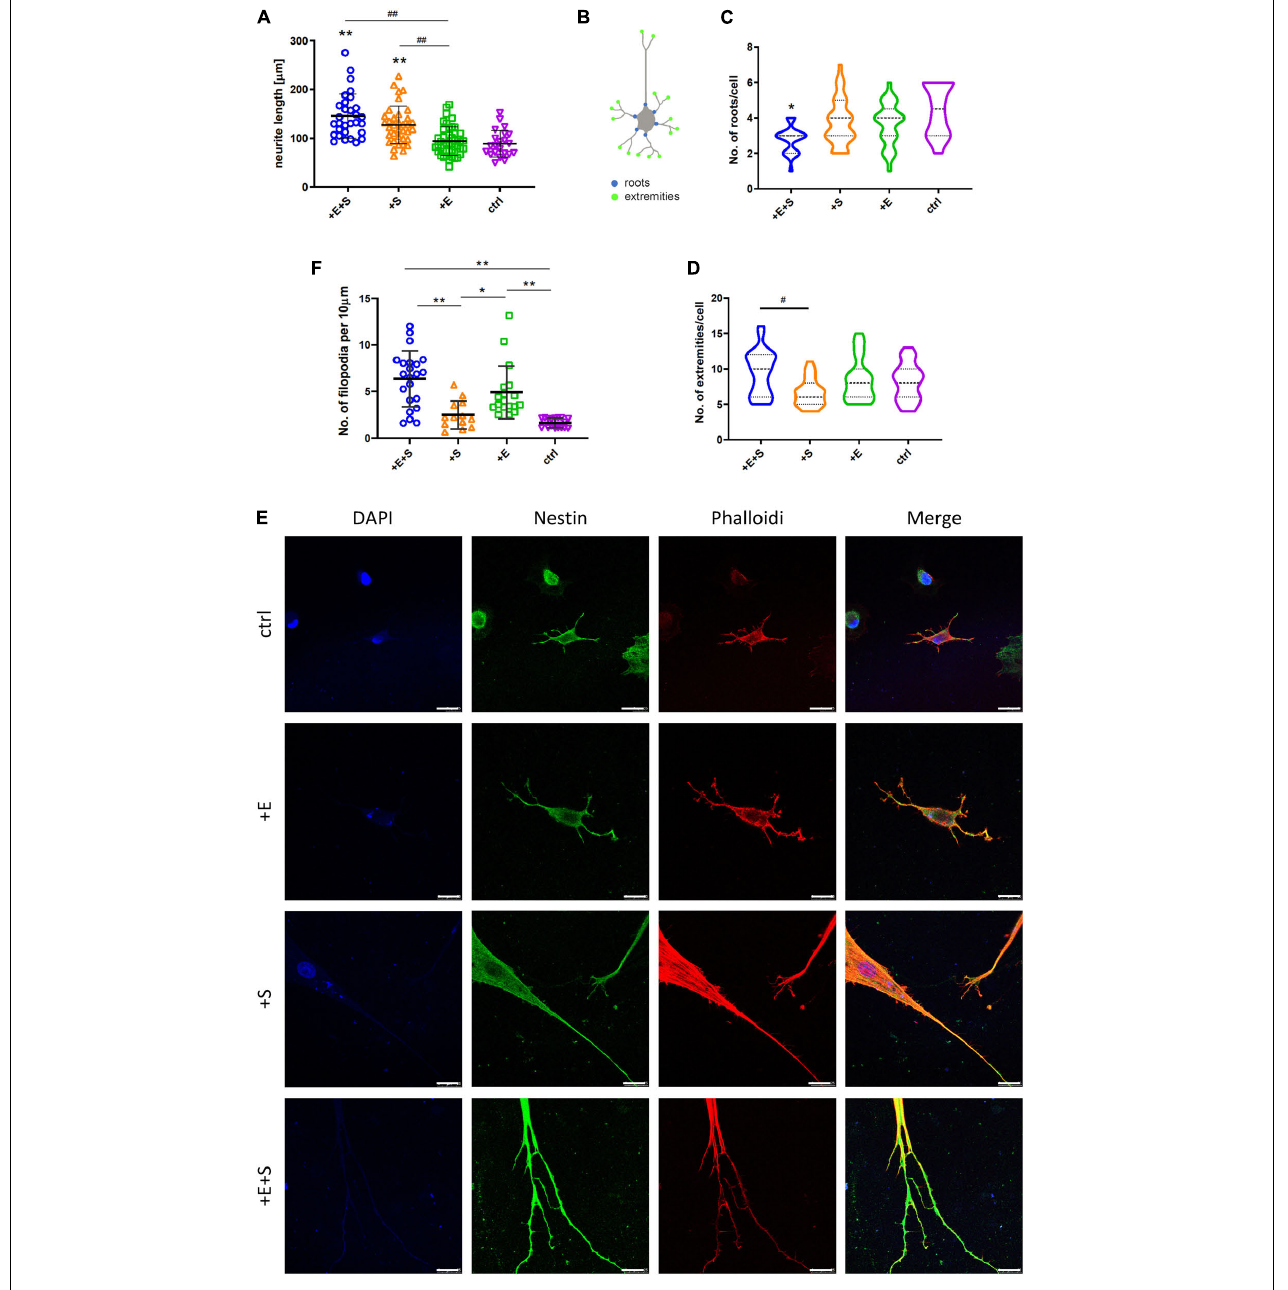
FIGURE 3 | BMSCs’ morphologic change under cyclical strain and electrical field stimulation. (A) Co-stimulation (+E +S) and strain (+S) significantly elongated neurites compared with static control (ctrl) (** p < 0.01) and electrical stimulation (+ E) ( ## p < 0.01, ANOVA). (B) Diagram of the roots and extremities of neurites. The numbers of roots (C) and extremities (D) of neurites under each treatment were counted manually from four independent experiments. Values are mean ± SD. (E) Immunocytochemistry detecting actin filament (red), nestin (green), and nucleus (blue) expression in rBMSCs under treatments (scale bar = 25 µ m). (F) Density quantification of filopodia under each treatment. The number of filopodia per 10 µ m of neurite was used to calculate the filopodia density (* p < 0.05, ** p < 0.01, ANOVA). # p < 0.05.